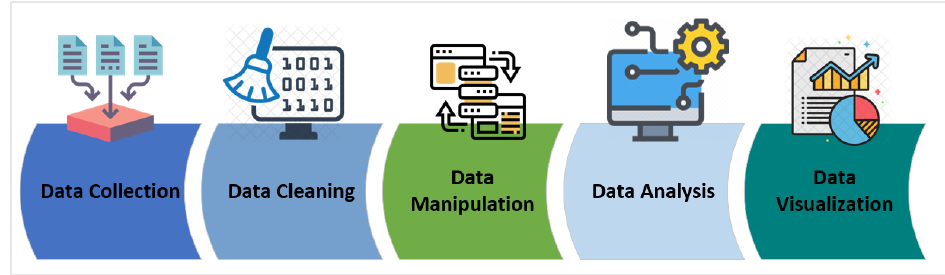
Figure 3. Data analysis main steps